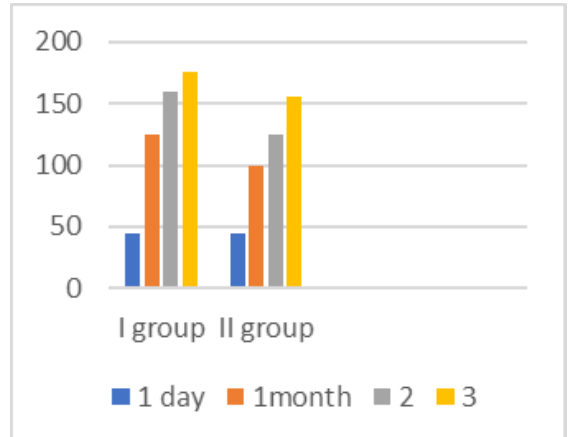
Figure 6. Dynamics of ROM flexion in degrees by months of